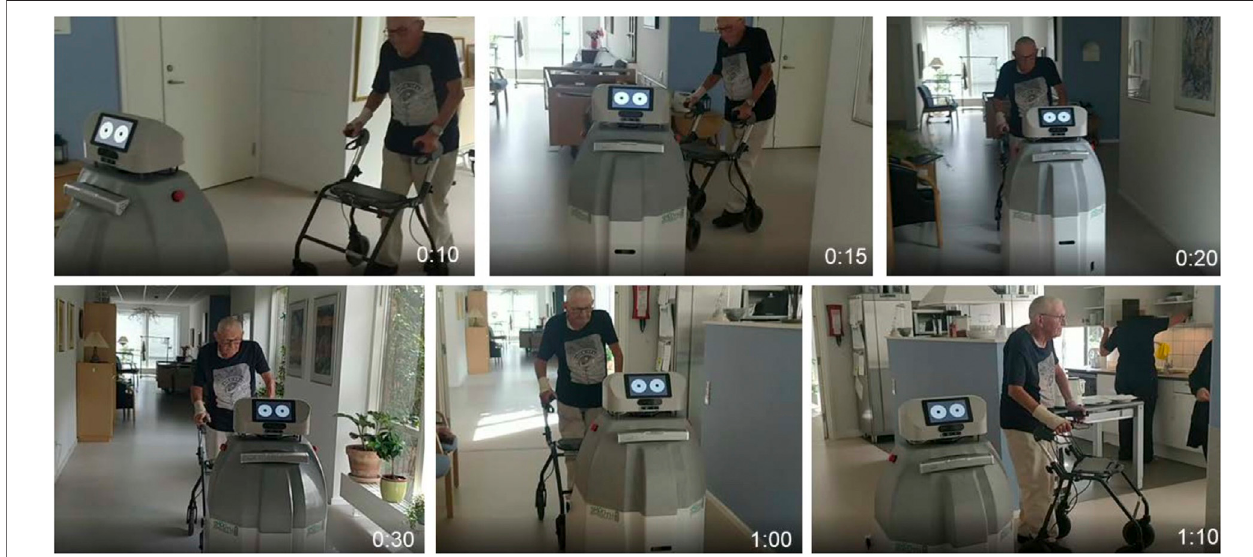
FIGURE12| SMOOTH-robotsuccessfullyguidedanelderlyresidentattheØlbyelderlycarecenterinKøge,Denmark.Itautonomouslynavigatedinthecenterand smoothly guided the resident without astop-and-go pattern from the living room tothe dining room over a distance of25 m. During guiding, it also adapted its speed to the human target for effective guiding. Furthermore, it also performed incremental monologue to encourage the resident to walk to the dining